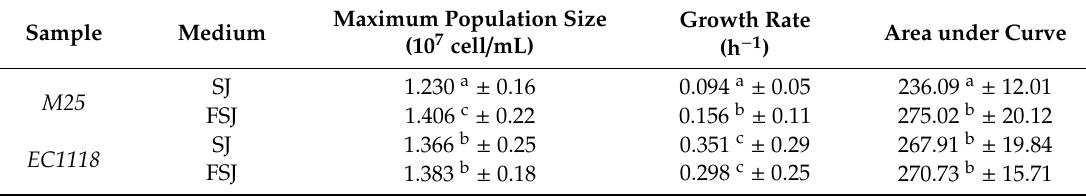
Table 1. Parameters for the logistic equation fitted on cell viability data of M25 and EC1118 strains growing in absence (SJ) and in presence (FSJ) of oleic acid and ergosterol supplementation.